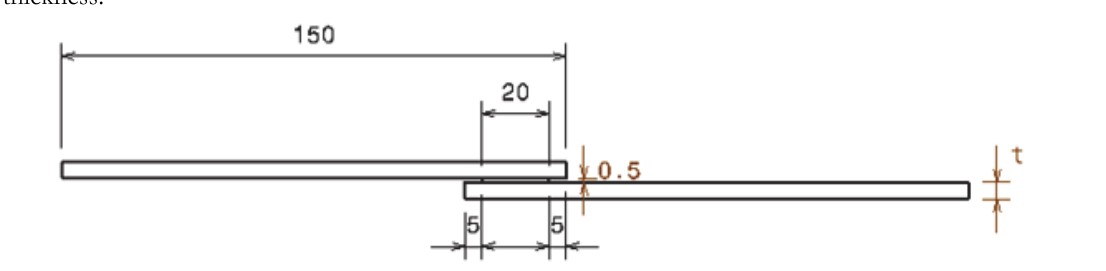
Figure 1: Dimensions of the single-lap joints.